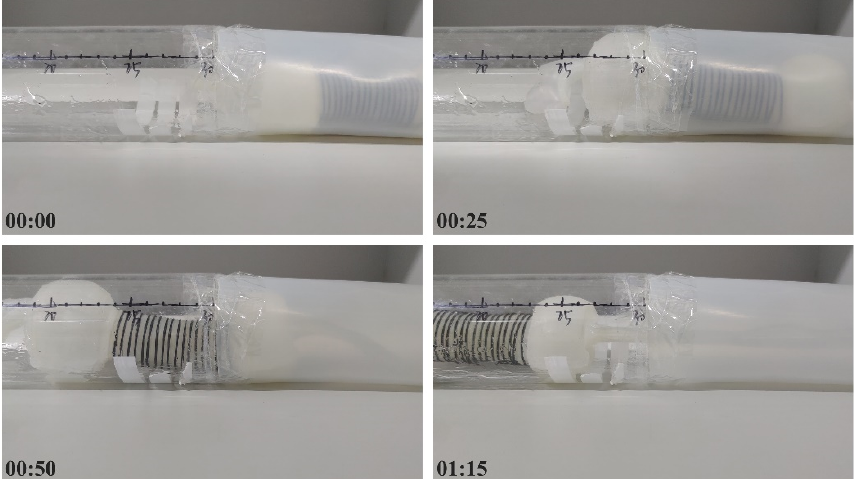
Figure 9. The intestinal soft robot moves from a flexible pipe to a rigid pipe. (The number represents the running time of the soft robot.)